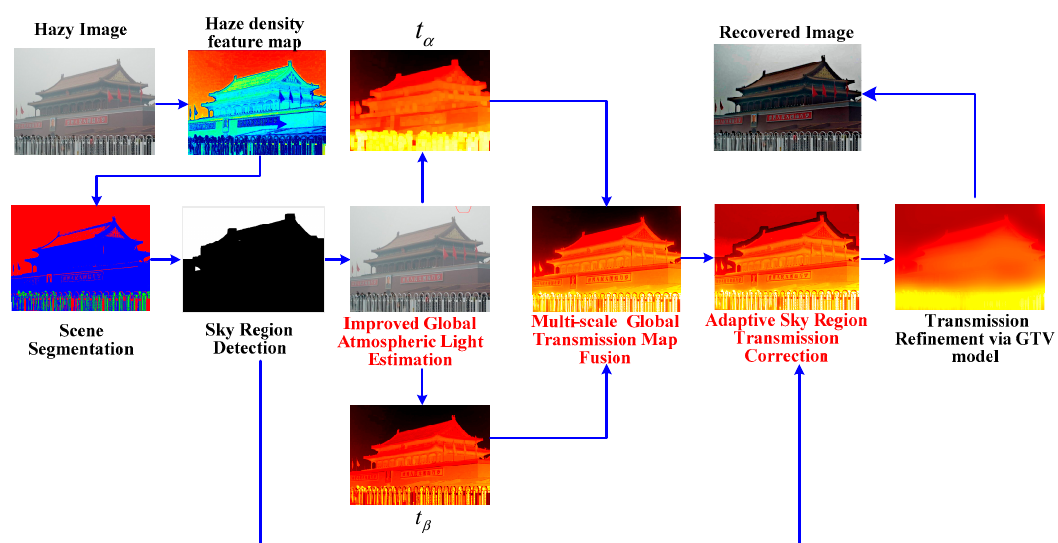
Figure 1. Overview of our method. From the input hazy image, we first detect the sky region based on the haze density feature map and scene segmentation technique. Then, we apply three key steps, including the improved global atmospheric light estimation, the multi-scale transmission map fusion and the adaptive sky region transmission correction. Next, we introduce the guided total variation (GTV) to further refine the transmission map and recover image via the atmospheric scattering model.